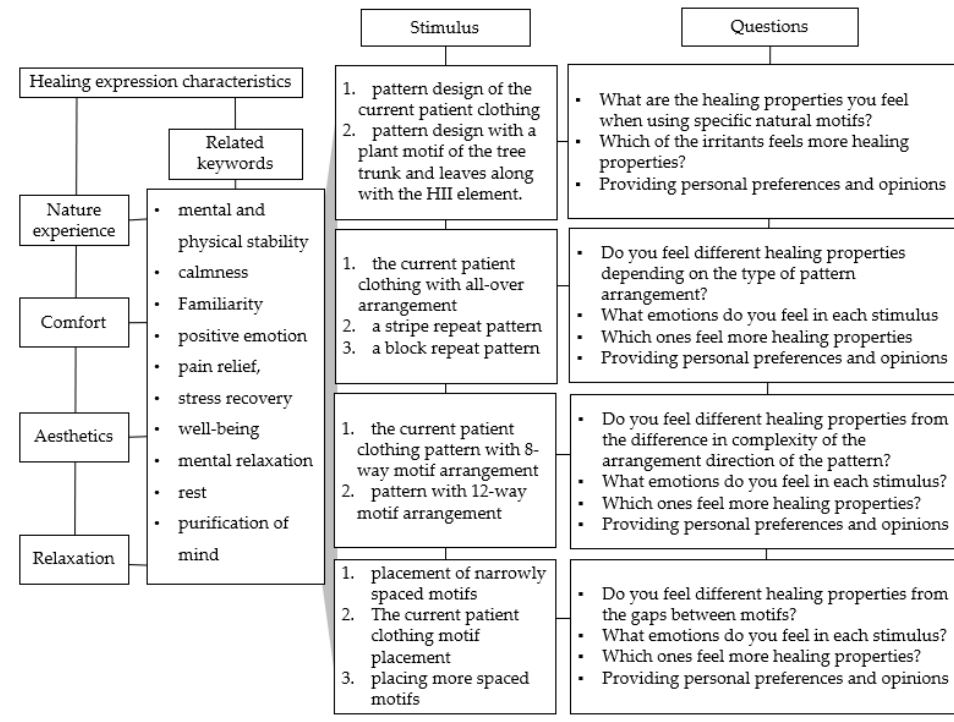
Figure 5. The question-extraction process for the patient ’ s emotional response to pattern design using HI . using